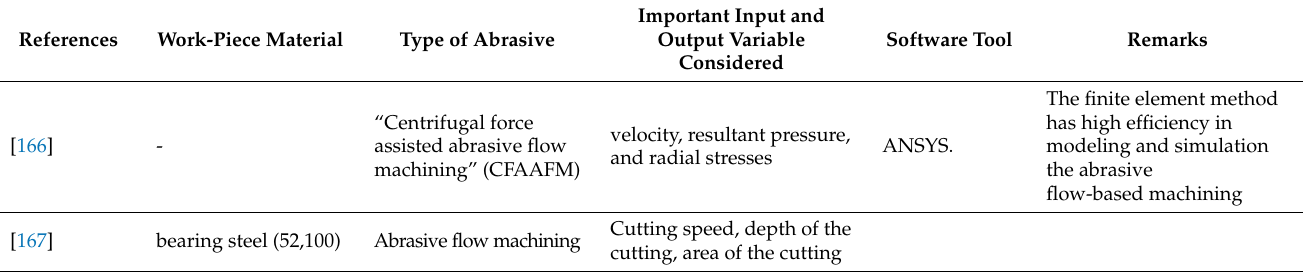
Figure 28. Vectors of particles’ velocity in different motion phases for the triangular wave at 70 Hz [165].